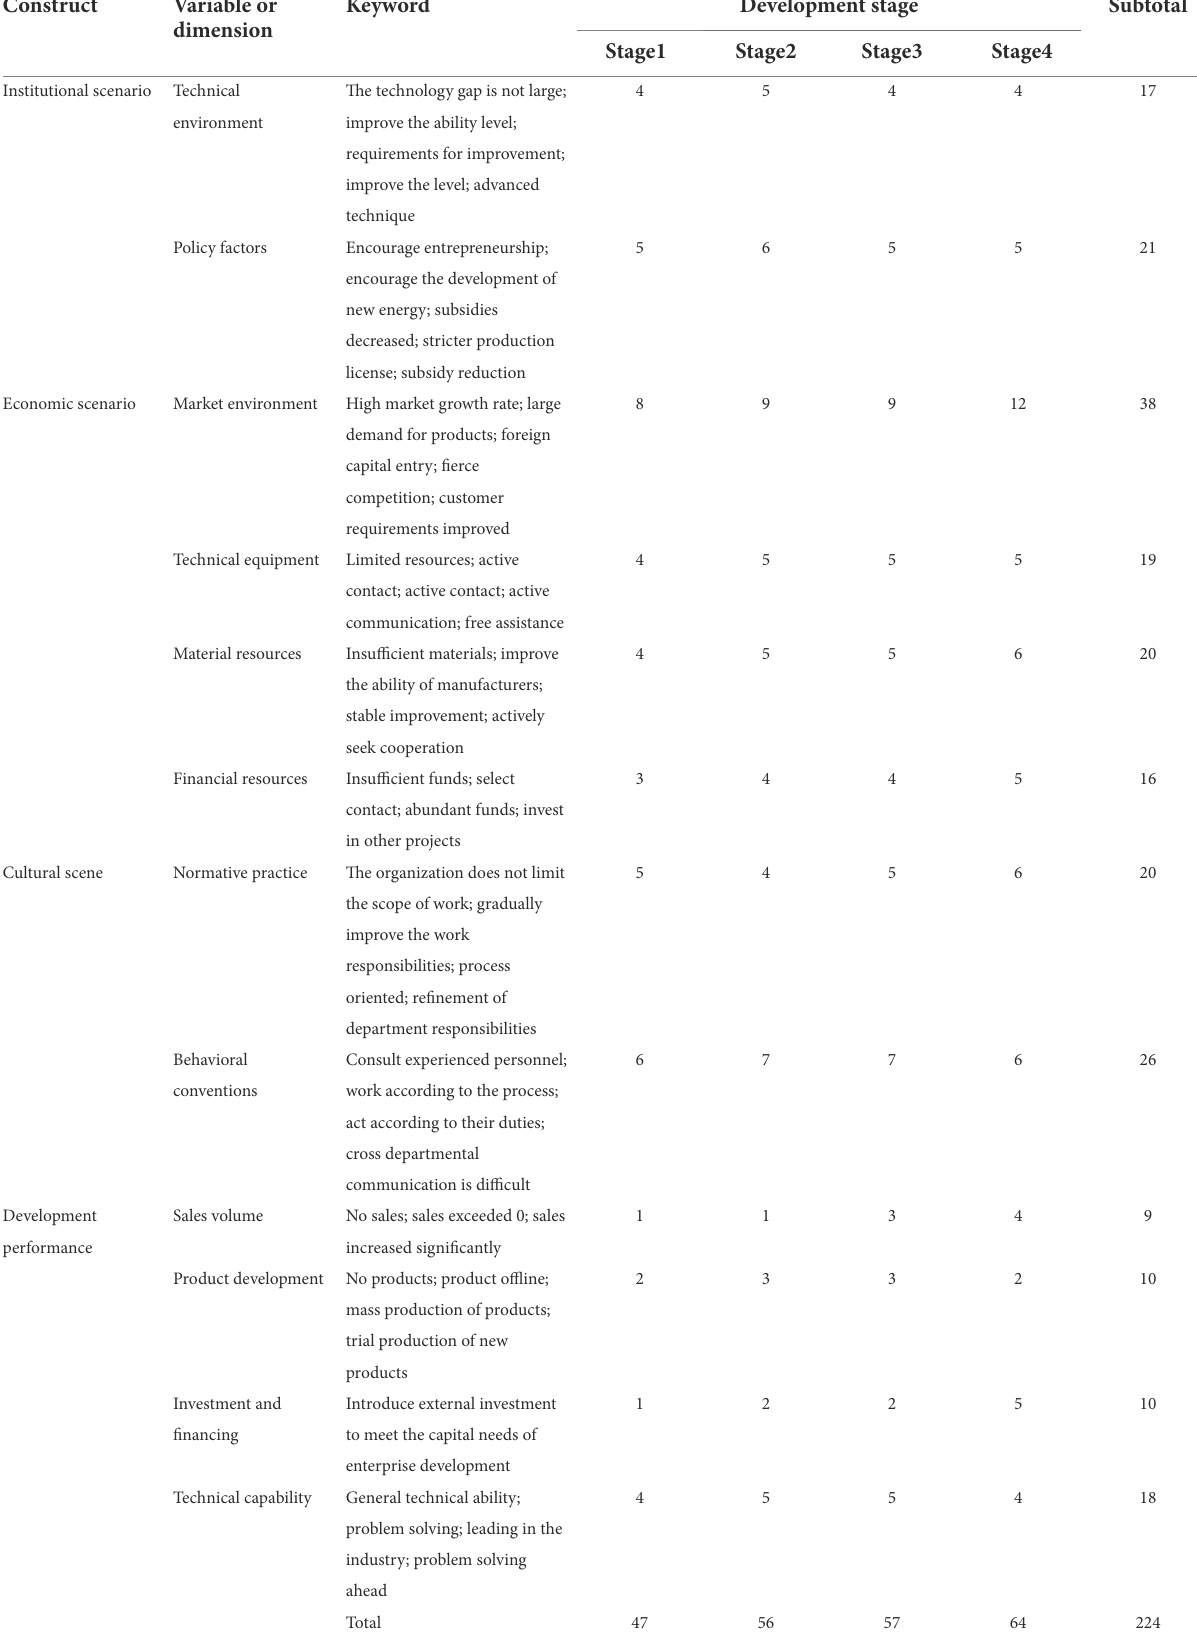
TABLE 3 Coding statistics of dimensions, measurement variables and keywords.